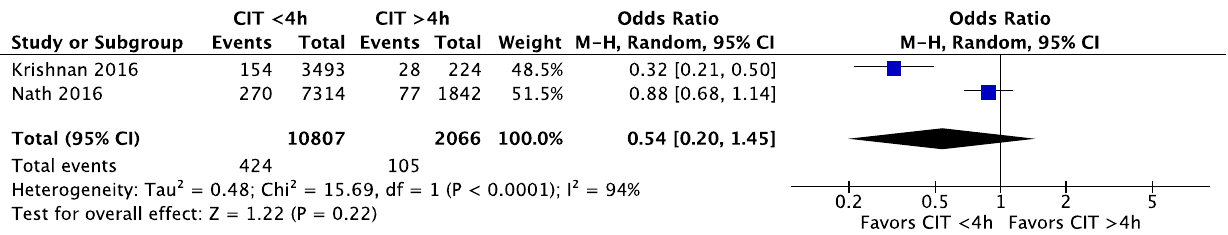
Figure 13. Five-year patient survival for CIT shorter and longer than 4 h. CIT: cold ischaemia time.